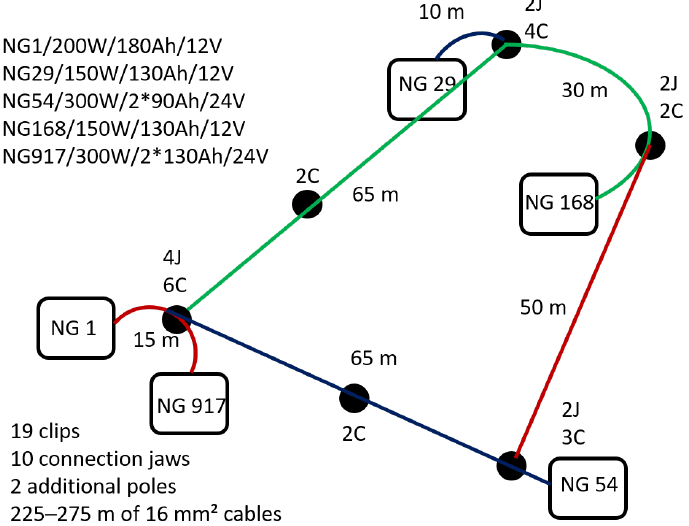
Figure 29. Schematic of the microgrid